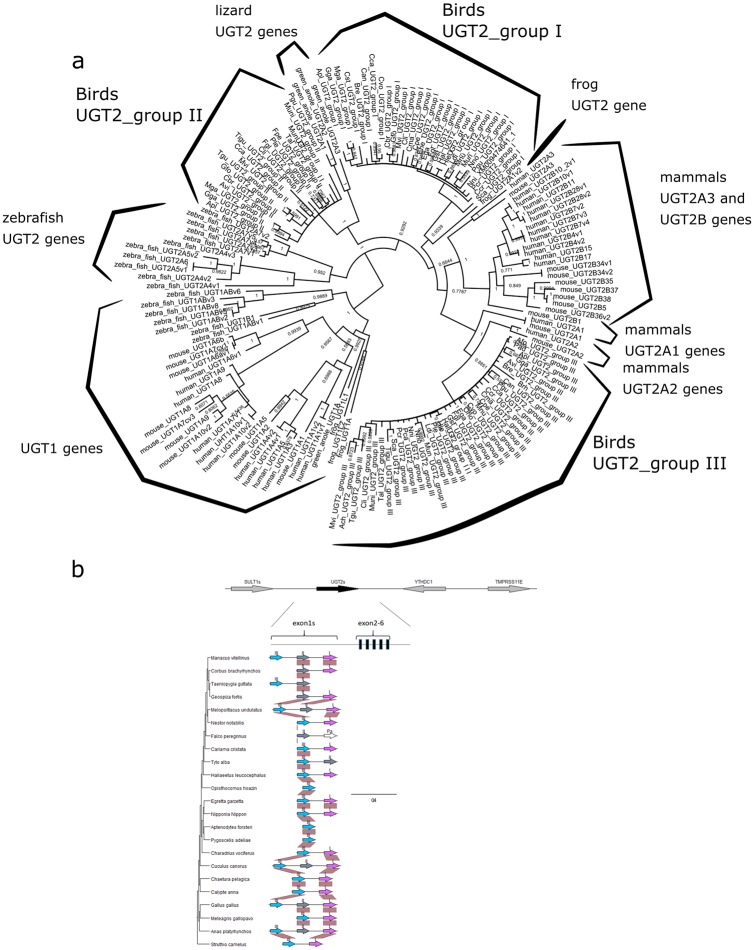
Classification of UGT2s in bird species.a) The phylogenetic tree based on avian UGT2 exon1 was constructed in mrbayes5d. Avian UGT2 exon1s are divided into 3 major groups (indicated with Roman numerals on arrows), with Group_I and Group_II forming a clade distinct from mammalian UGT2. However, bird UGT2 Group_III genes formed a single clade with mammalian UGT2A1 and UGT2A2. b) Avian phylogeny and gene locations of avian UGT2 genes were visualized in genoplotR. All UGT2 information was retrieved from a single contig. Avian UGT2s were located between “SULT1” and “YTHDC1.” Exons2-5 were shared across every avian species. Synteny of UGT2 exon1 was well conserved in birds.